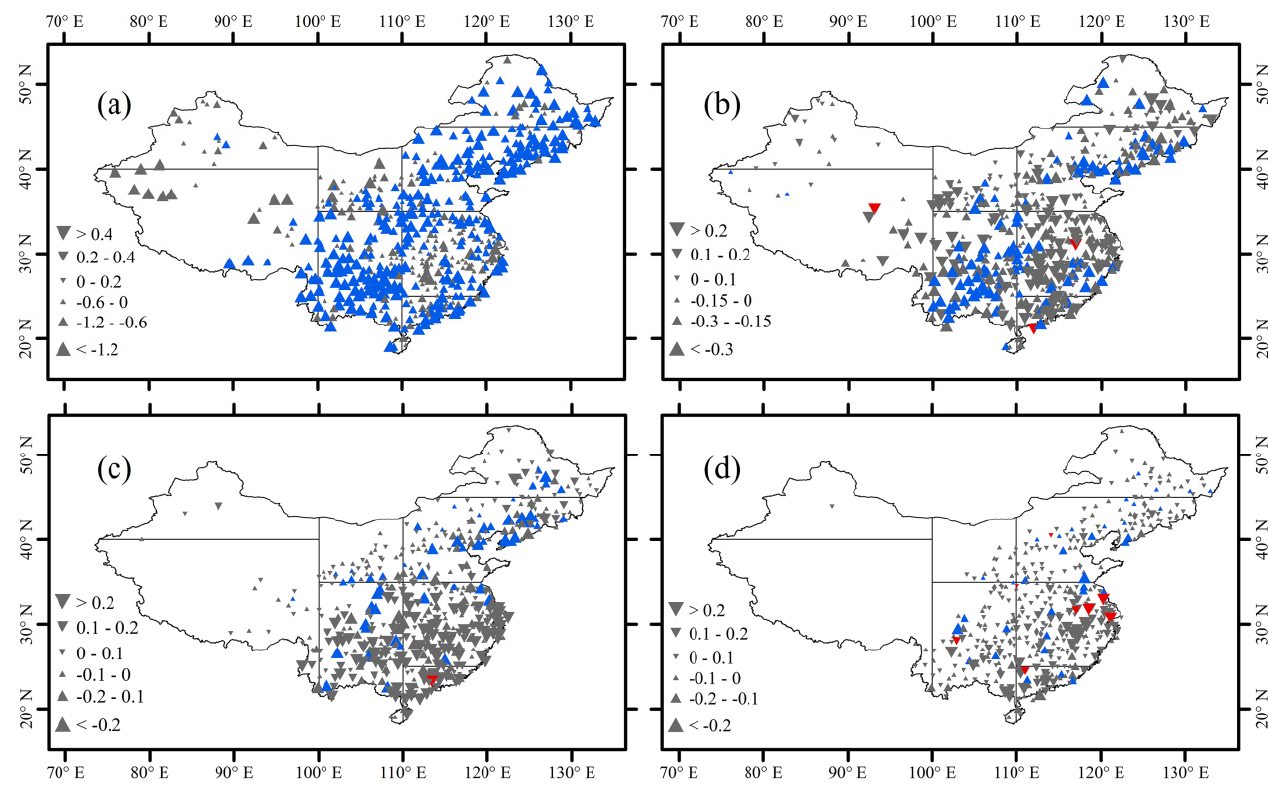
Figure 5. Changes of precipitation days (days/decade) (( a ) light precipitation, ( b ) moderate precipitation, ( c ) heavy precipitation, and ( d ) very heavy precipitation) during the rainy season over China from 1960 to 2018. Upward and downward triangles represent positive and negative trends, respectively. Blue and red triangles denote significant trend at the 90% confidence level.